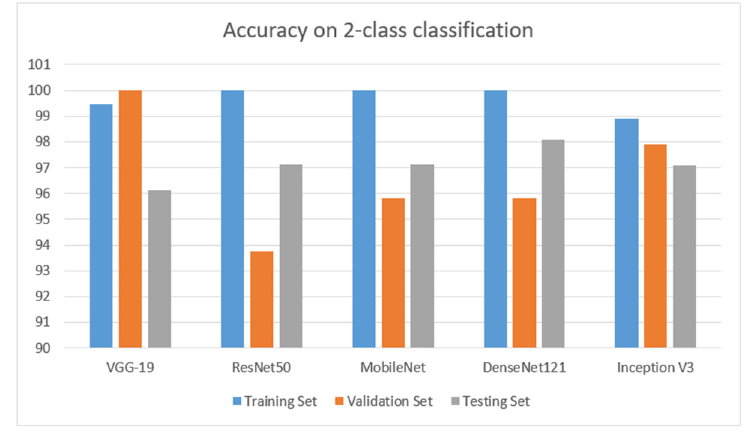
Figure 8. The plot shows accuracies compared for the 2-class classification.